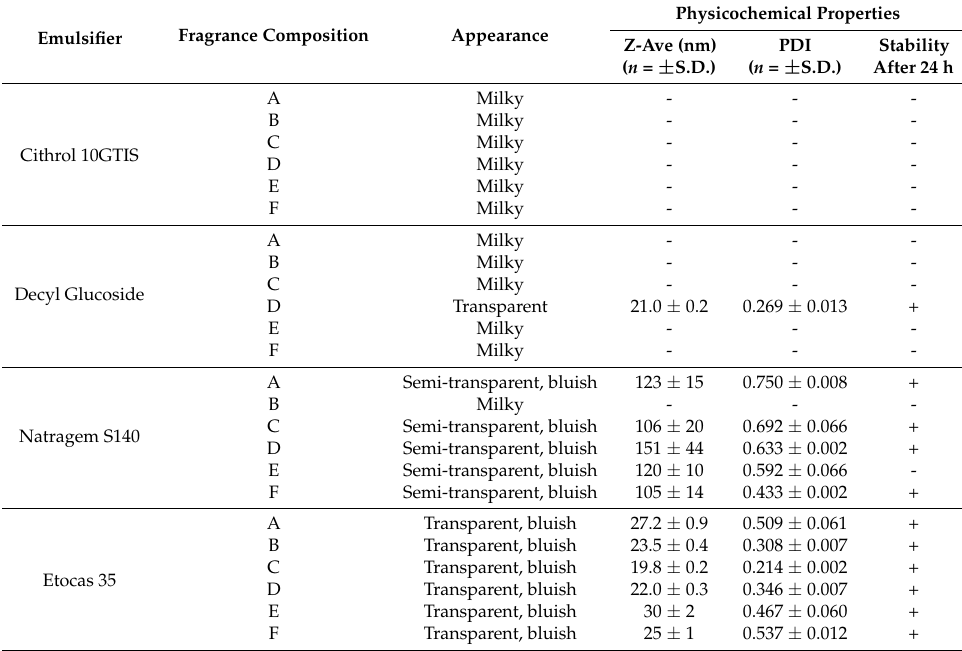
Table 3. The influence of a fragrance composition (O) and emulsifiers (S) on the physicochemical properties of nanoemulsions (ratio S:O = 0.625:0.375) obtained with both methods.